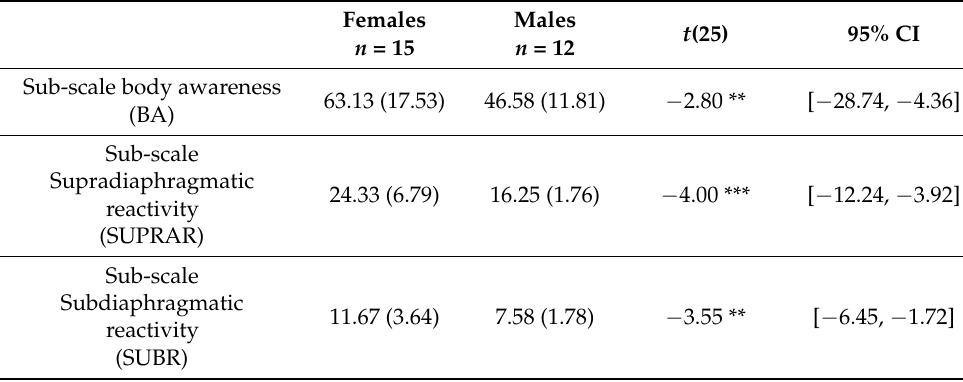
Table 8. Means, standard deviations (SD), statistical parameters, and significance levels of the BPQSF subjective rating by